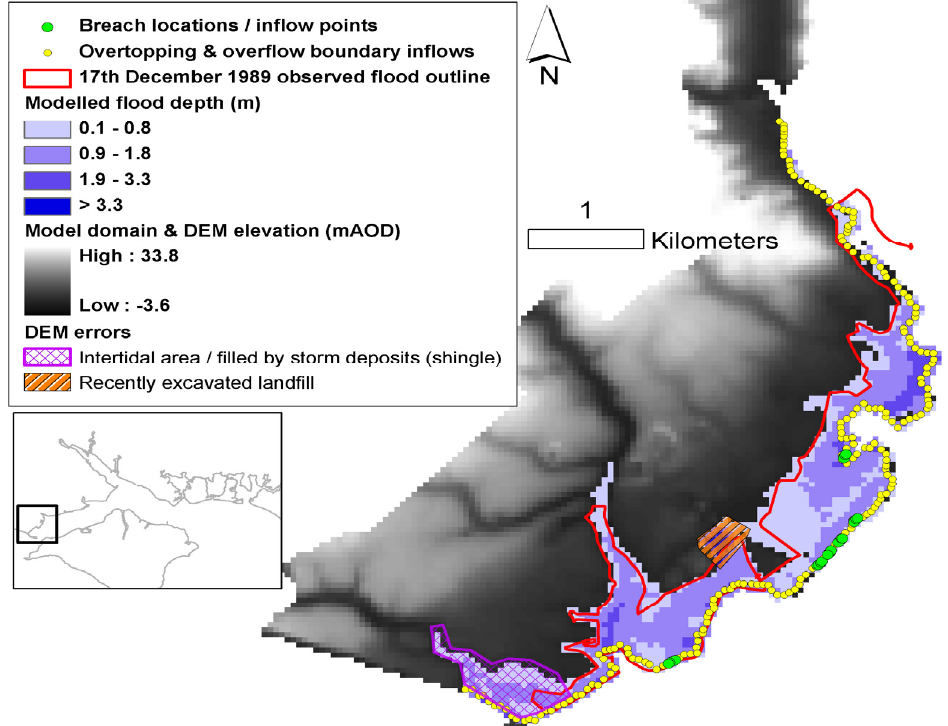
Figure 8. The 17th December 1989 flood simulation and observed flood outline. A boundary water level of 2.1 mAOD recorded at Lymington [88] was applied across